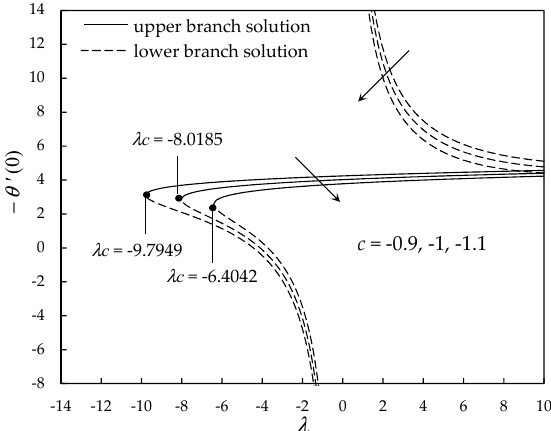
Figure 10. Variation of the reduced skin friction coefficient of f (cid:48)(cid:48) ( 0 ) with the mixed convection parameter λ for several values of c (shrinking sheet) when φ = 0.01, Nr = 0.1, K = 0.1 and s = 1 for Cu-water nanofluid.